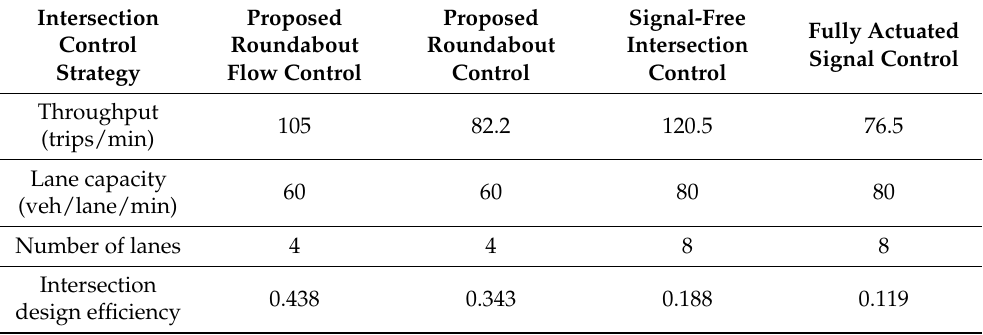
Table 3. Performance